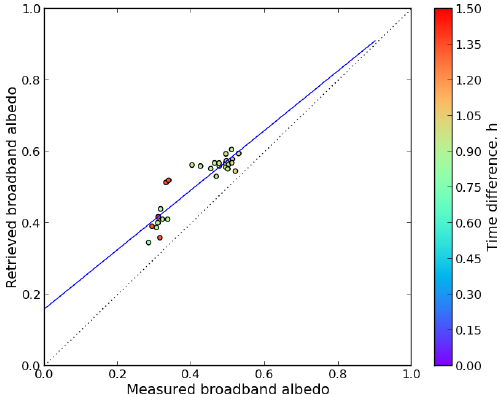
Figure 8. Correlation between broadband albedo retrieved from airborne measurements (MELTEX campaign) and from a satellite overflight, respectively, for the 7 June 2008, with respect to the time difference. N = 30, R 2 = 0.82, RMS = 0.096.